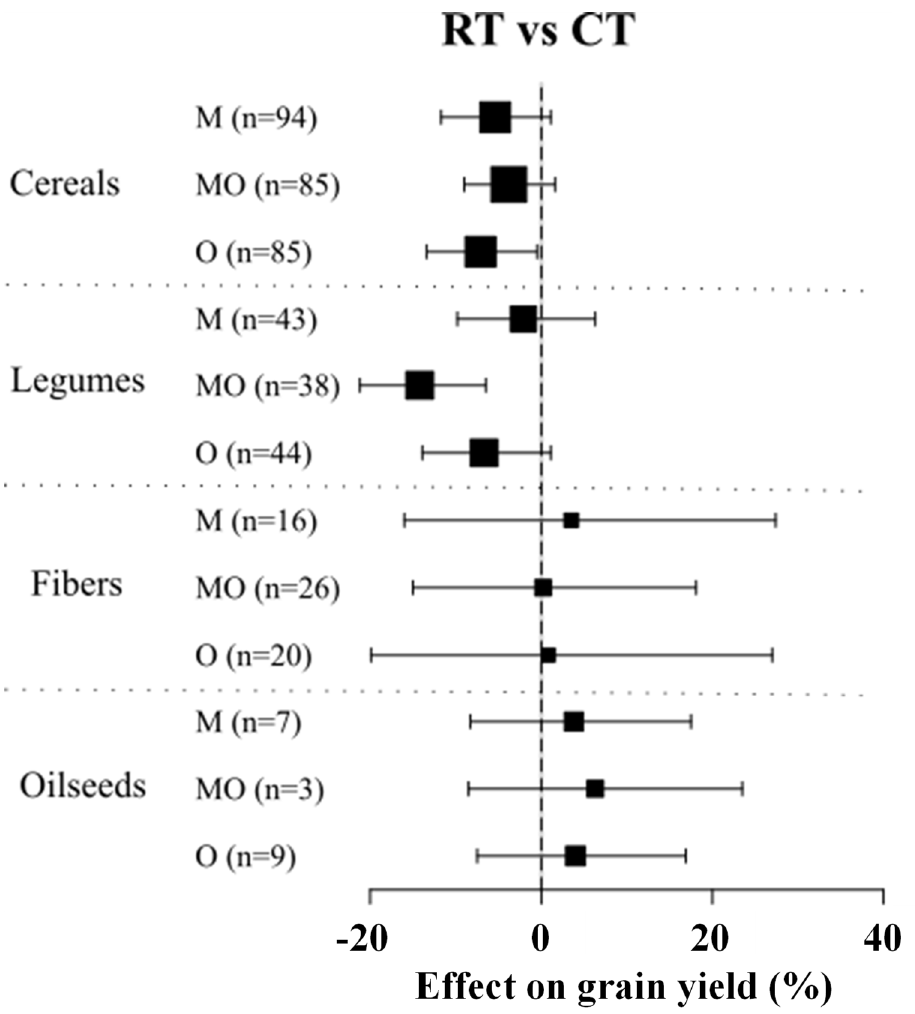
Figure 5. The response of reduced tillage vs. the conventional tillage practices (RT vs. CT), under different nutrient sources; inorganic (M), organic (O) and inorganic + organic (MO), for different crop species, expressed as the average effect on grain yield (%). “n” refers to the number of observations for each subgroup. The vertical line represents the null hypothesis [ln (RR) = 0], the squares are the point estimate of effect size, and the horizontal lines are the associated 95% confidence interval for the population parameter.